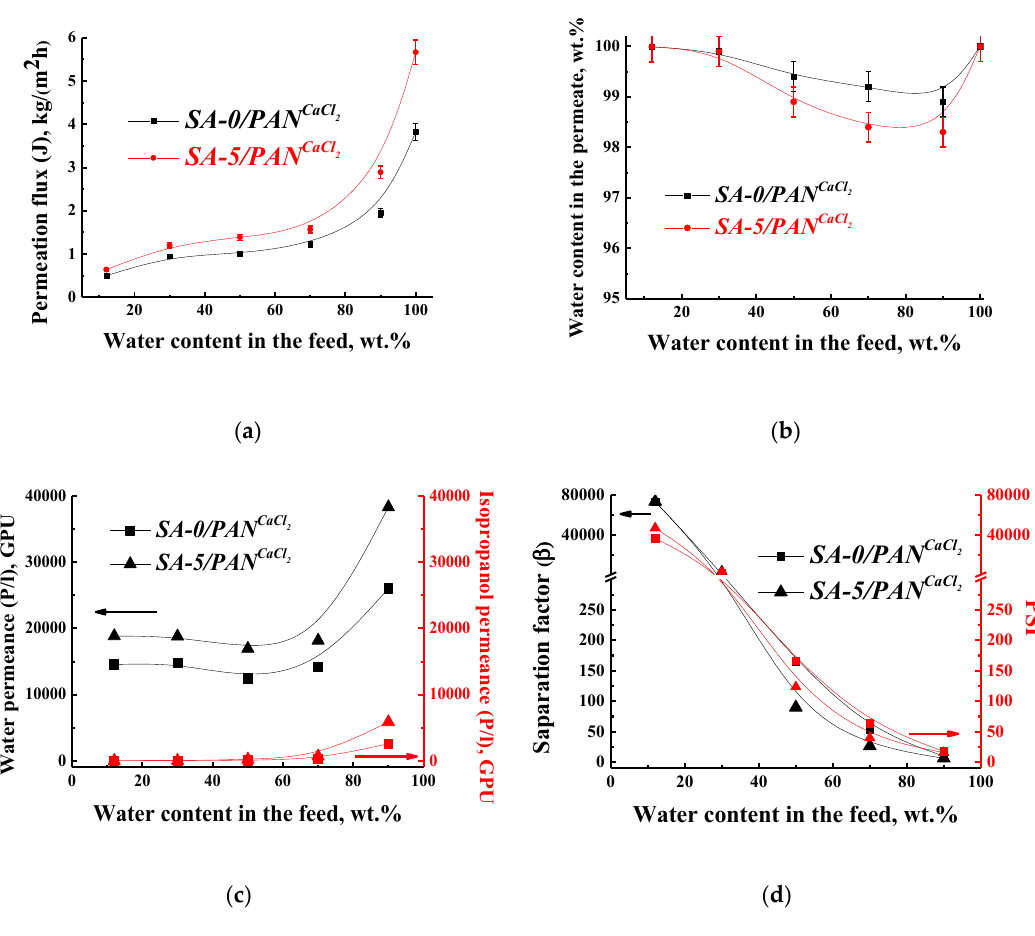
Figure 11. The dependence of ( a ) permeation flux and ( b ) water content in the permeate, ( c ) water and isopropanol permeances, ( d ) separation factor and PSI on water content in the feed during pervaporation of water–isopropanol mixture at 22 °C for cross-linked supported SA-0/PAN CaCl2 and SA-5/PAN CaCl2 membranes.